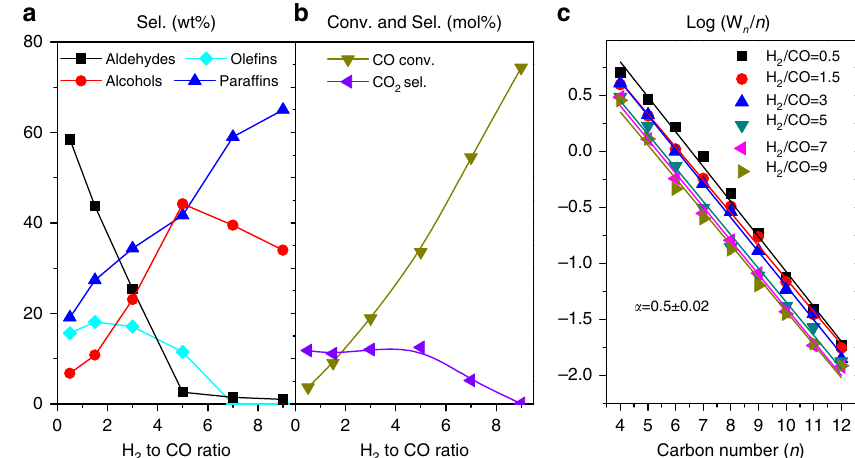
Figure 3 | Effect of H 2 to CO ratio. ( a ) Products selectivity without CO 2 , ( b ) CO conversion and CO 2 selectivity, ( c ) ASF behaviour for total C n of the same catalyst showing a chain-lengthening probability independent of the H 2 /CO pressure ratio. Reaction conditions: Co 4 Mn 1 K 0.1 catalyst 0.5g, 220 (cid:2) C and 40bar. The same batch of catalyst was subjected to conversion at different H 2 /CO ratios (sequential increase from 0.5 to 9 every 24h). The total time on stream of the catalyst was 144h. See also Supplementary Fig. 6 for long-term stability